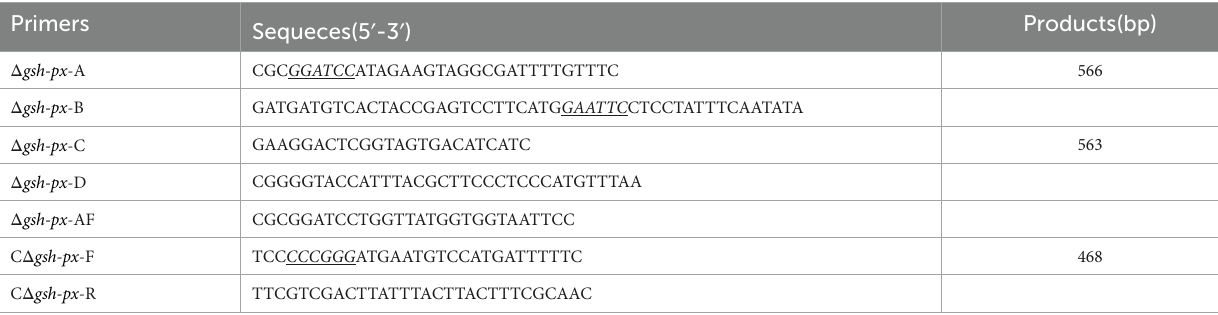
TABLE 1 The PCR primers used in this